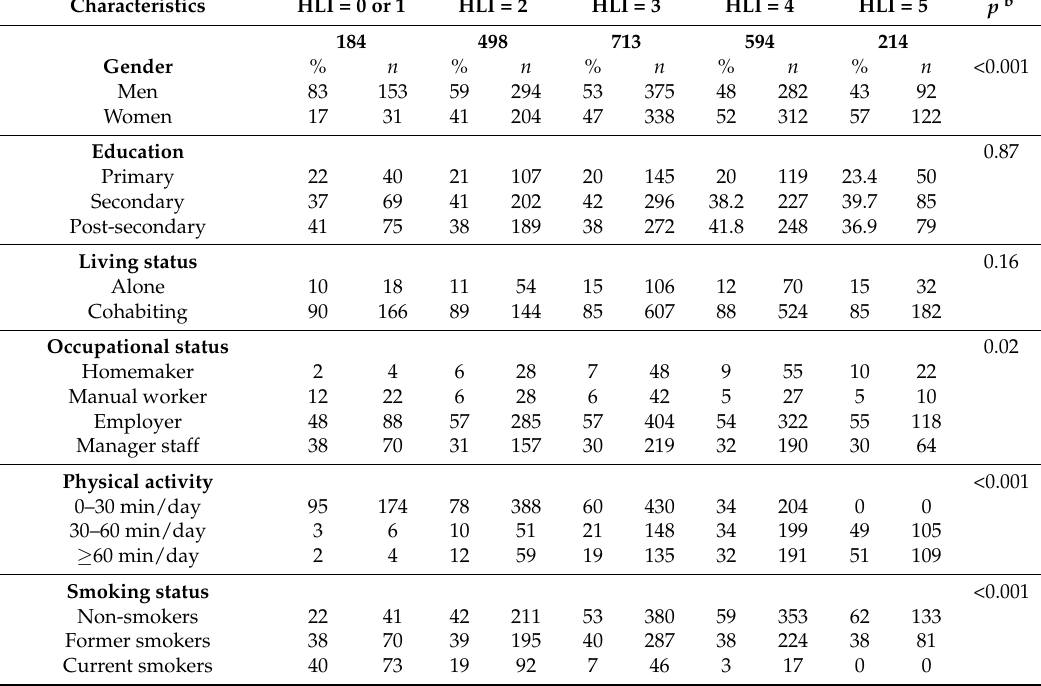
Table 1. Baseline characteristics of the study population across classes of healthy lifestyle index (HLI; N = 2203) a .